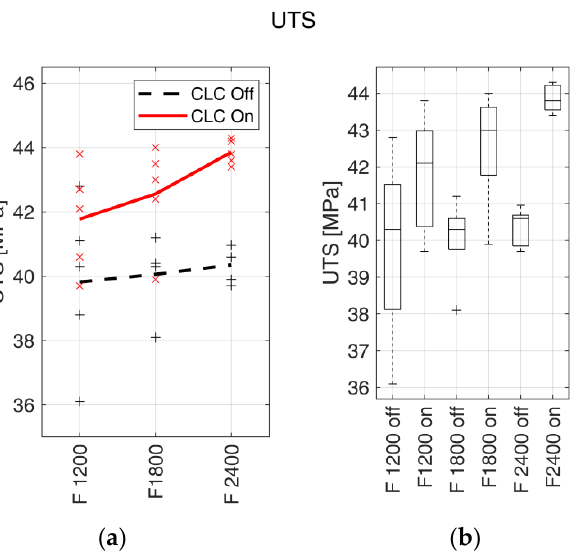
Figure 7. UTS. ( a ) UTS trends with respect to the fabrication feed rates (expressed in mm/min). Markers indicate the measured values for each test, and bold lines indicate the mean values. The continuous red line indicates the samples realised with enabled CLC, and the black dashed line indicates the samples realised with disabled CLC. ( b ) Box plots of UTS vs. filament feed rate with enabled (on) and disabled (off) CLC.